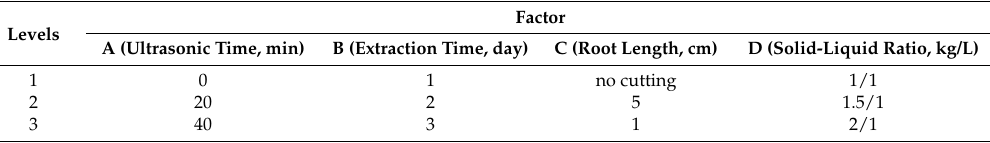
Table 1. Factors and levels of orthogonal experimental design.